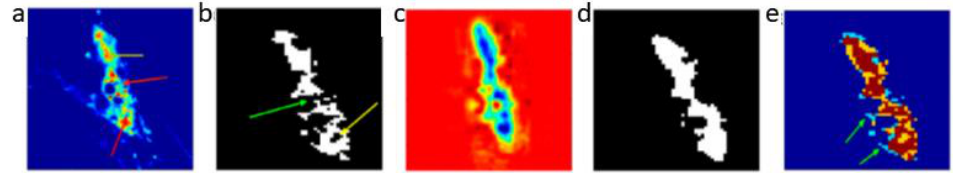
Figure 4. Tumour segment reconstruction from multiple channels. ( a ) Illustration of intensity variation for breast tumour tissue images; the yellow arrows indicate a high intensity whereas the red arrows low intensity. ( b ) Illustration of fuzzy c means (FCM) based segmentation on ( a ) assuming inhomogeneous boundaries; the yellow arrows indicate an irregular ring-shaped region and a green arrow indicates missing pixels in the segmented object. ( c ) Reconstructed volume image from multiple channels. ( d ) The tumour segment after reconstruction. ( e ) Overlapped images (brown) of the original tumour segment (blue) and reconstructed tumour segment (yellow). The green arrows indicate the fuzzy edges associated with the original image. Images depict an in-situ ductal carcinoma based on [52].